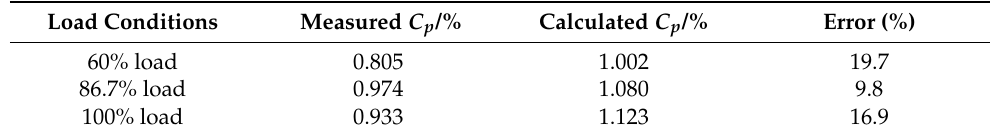
Figure 12. Comparison between the calculated and measured results. Table 3. Comparison between the calculated and measured results ( f / f n =